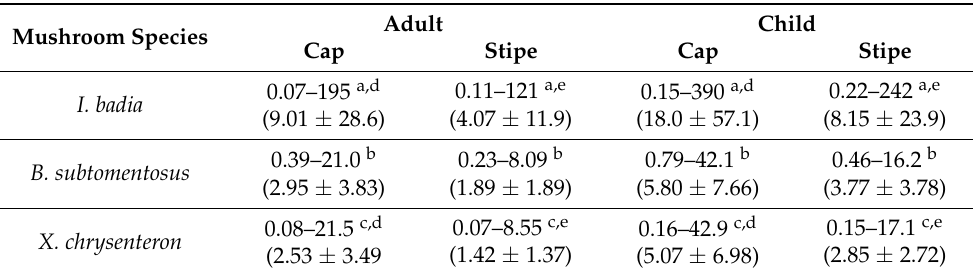
Table 5. Percentage of the PTWI estimated on Hg content (min-max (average ± st.deviation)), separately in caps and stipes of three analysed mushroom species, considering the age of the consumer. The results of the Kruskal-Wallis test expressing the significant differences ( d,e p < 0.001) between species in PTWI contribution and the results of the Mann-Whitney U test expressing significant differences ( a,c p < 0.001; b p < 0.05) in PTWI contribution between mushroom parts of individual mushroom